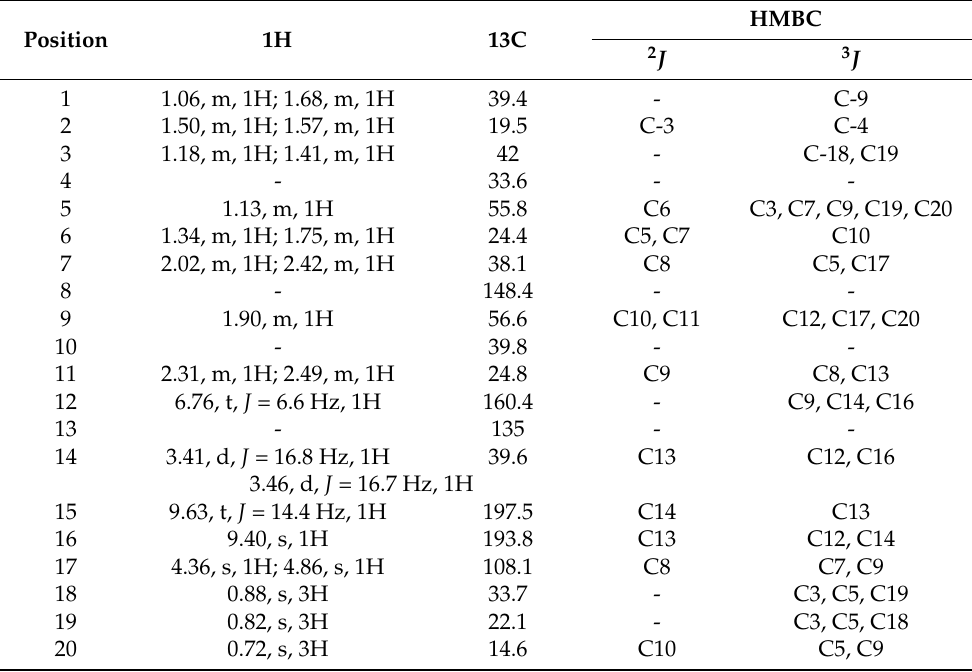
Table 2. 1 H- (600 MHz), 13 C- (150 MHz) NMR and HMBC (600 MHz) data of 1 in CDCl 3